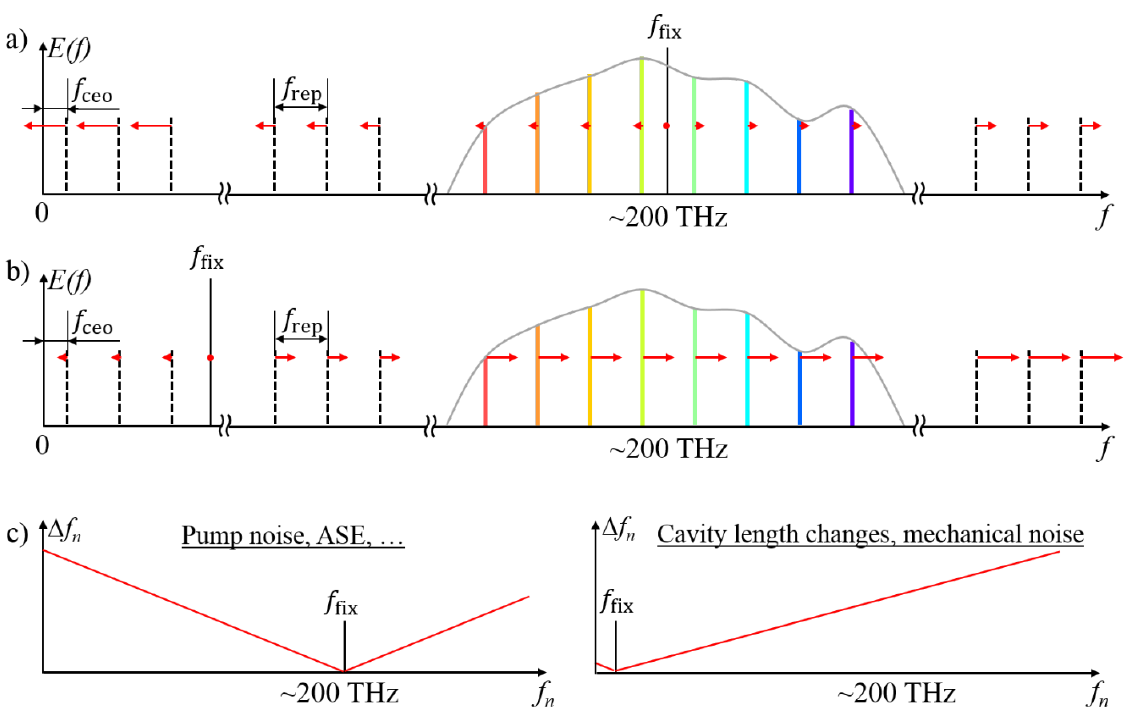
Figure 5: Fixed points, f fix , of an erbium fiber frequency comb. Comb teeth under the optical spectrum (gray) are indicated by solid lines, while virtual teeth are indicated by dashed lines. a) For the case of pump power modulation, the fixed point is near the optical carrier fre- quency (~200 THz) with large tooth fluctuations (indicated by the length of the arrows) near 0 Hz. b) For the case of cavity length modu- lation via a piezo-electric transducer (PZT), the fixed point will be close to 0 Hz with large fluctuations at the optical carrier frequency. c) Depiction of the impact, ∆f n , of a given perturbation at different tooth frequencies, f n , in the